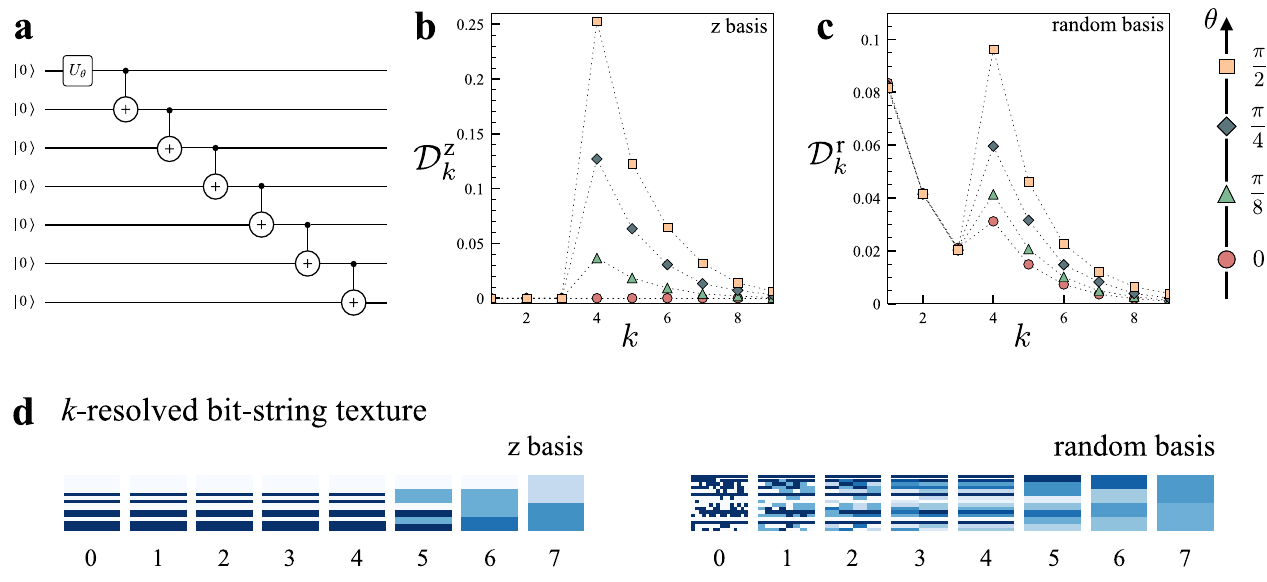
Fig. 2 Dissimilarity results for Schrödinger cat states. a Quantum circuit generating Schrödinger cat states. b , c Partial dissimilarities D k of 16-qubit Schrödinger cat states calculated in the σ z and the random bases correspondingly. Here, Λ = 2. The peak at k = 4 is due to the fact that the coarse-graining window becomes of the size of the system at this scale, Λ k = N . d Visualization of bit-string arrays. In these images, individual bitstrings are horizontal lines of 16 bits that are concatenated to form a long string (stacked here vertically for the purpose of in the σ z basis, and the right one — measured in the presentation). Left picture shows an example of array sampled from a cat state with θ ¼ π 2 random basis. Here k = 0 represents texture of the measured array per se, and k > 0 show its evolution upon